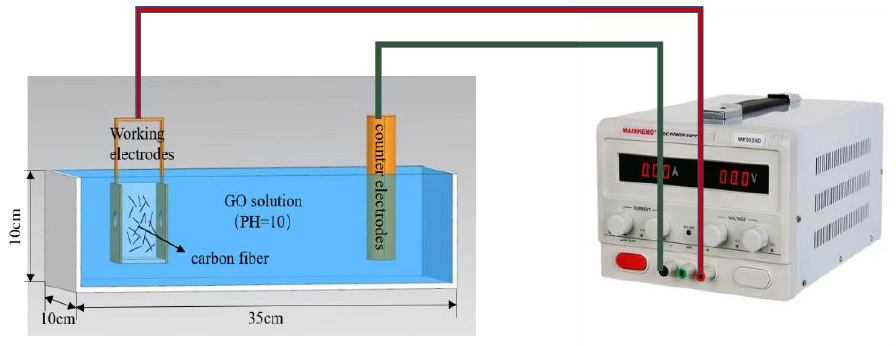
Figure 3. Diagram of EPD.